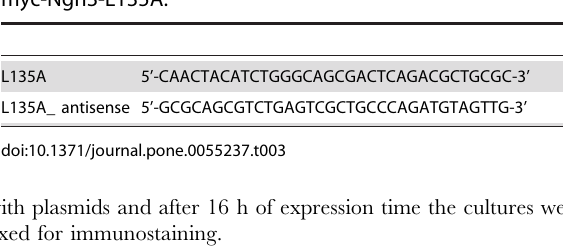
Table 3. Primer sequences used for construction of pCS2-